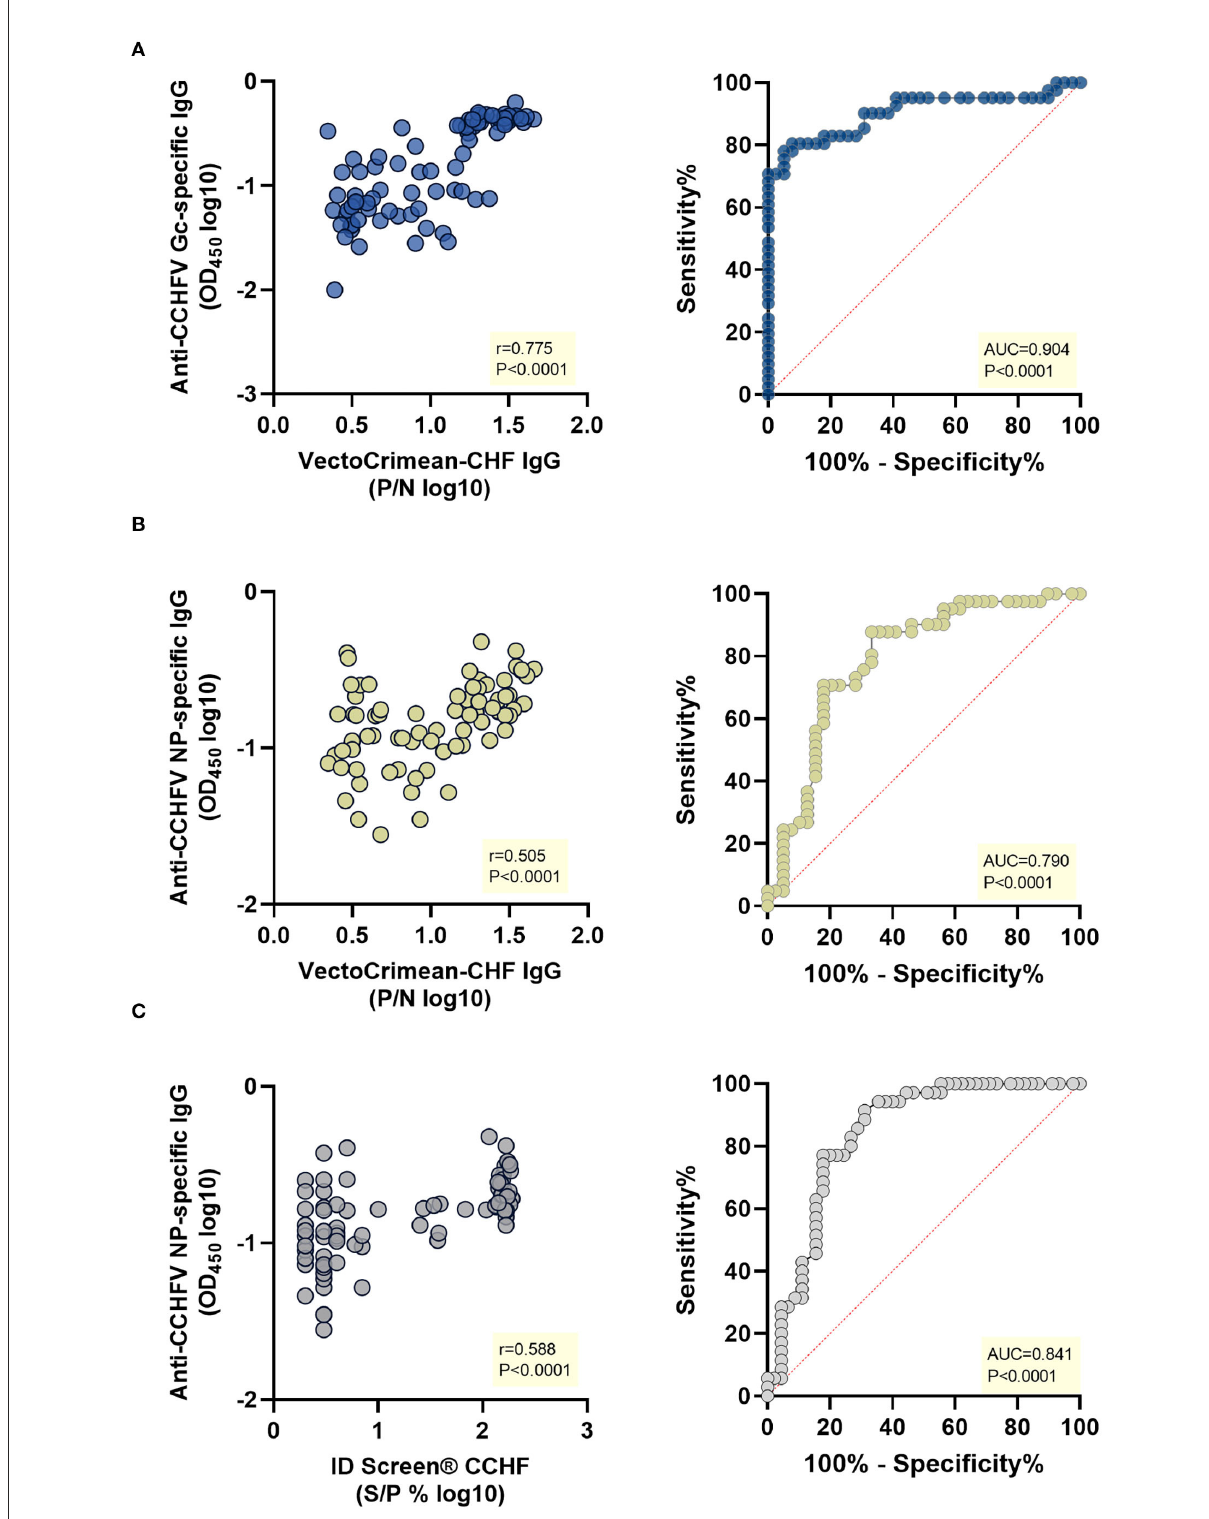
FIGURE3 Correlation and receiver operating characteristic (ROC) analysis of anti-CCHFV Gc-specific and anti-CCHFV NP-specific IgG in-house ELISAs vs. VectoCrimean-CCHF IgG and ID Screen ® CCHF Double Antigen Multi-species commercial kits. A subset of sheep sera collected as part of a